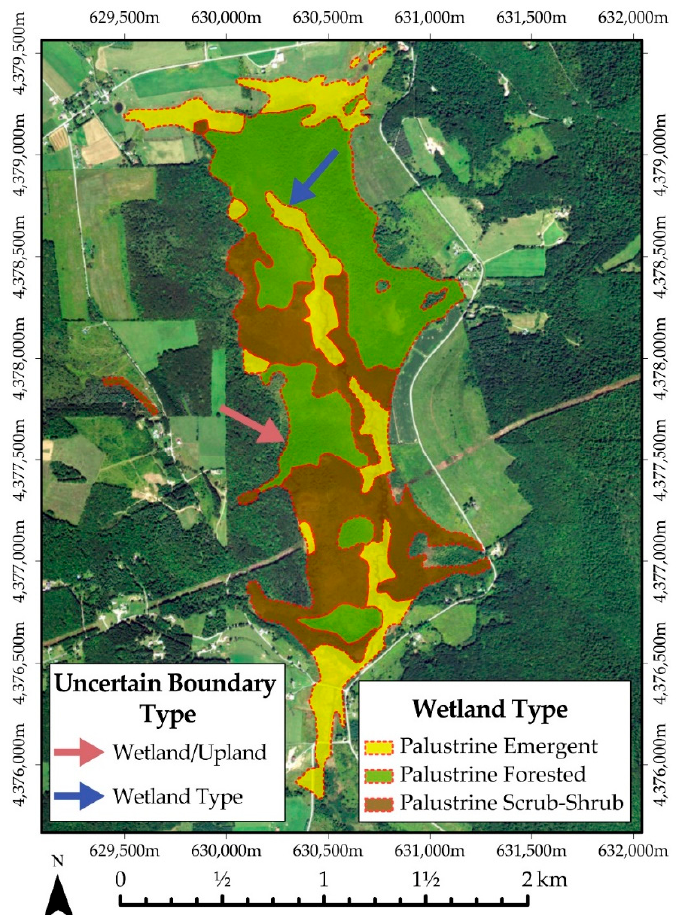
Figure 1. Example of inherently uncertain wetland boundaries. The arrows highlight examples of uncertain boundaries (wetland / upland and wetland type) to which the proposed assessment method is applicable. Wetland data are from the National Wetland Inventory (NWI) and background orthophotography are from the 2016 National Agriculture Imagery Program (NAIP). The coordinate grid represents easting and northing relative to the NAD83 UTM Zone 17 North projection.